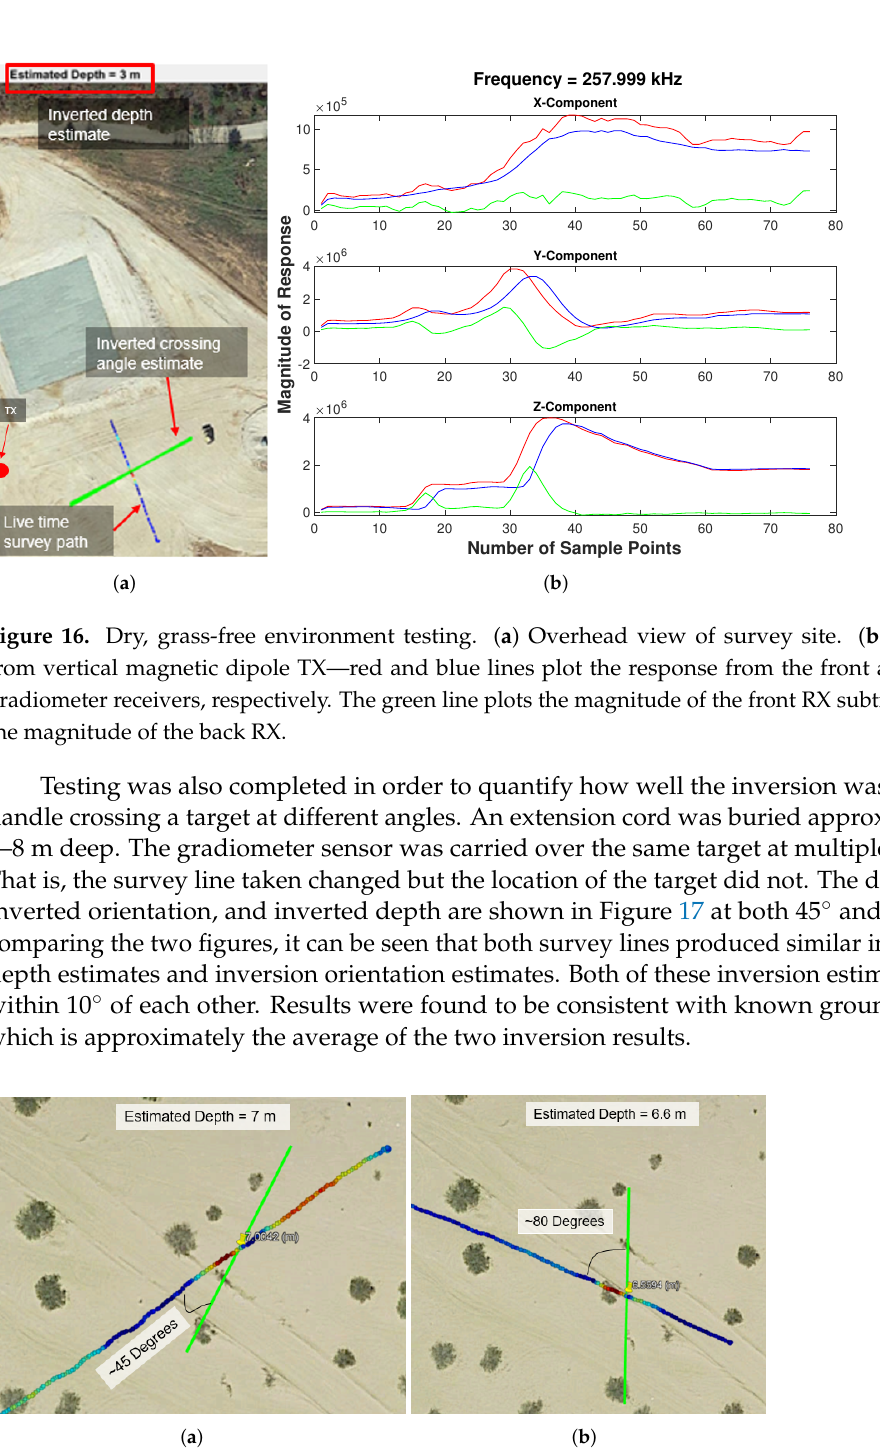
Figure 17. Inversion testing for multiple survey line crossing angles. ( a ) Survey line 45 ◦ to the target. ( b ) Survey line 80 ◦ to the